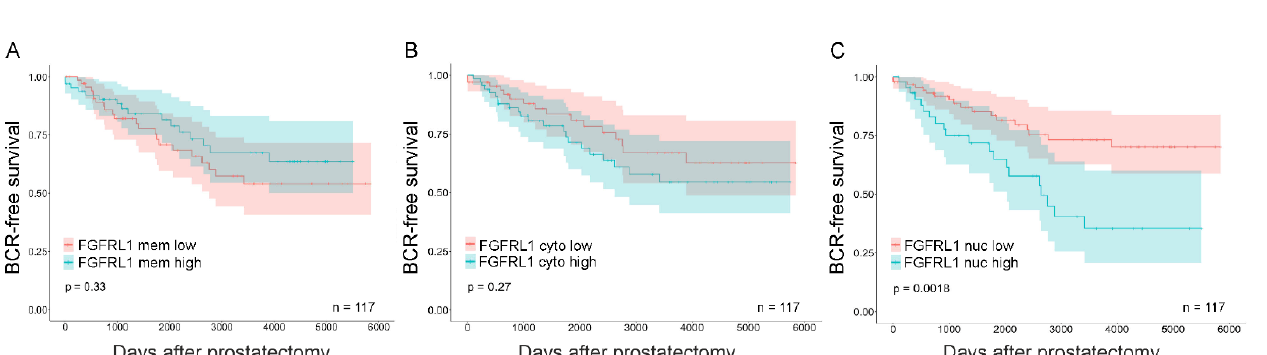
Figure 2. Kaplan–Meier analysis for membrane, cytoplasmic, and nuclear FGFRL1 expression associated with BCR-free patient survival in primary PCa. Primary PCa cases were stratified based on localized FGFRL1 IHC score. ( A ) low cell membrane (FGFRL1 mem low, red) versus high cell membrane (FGFRL1 mem high, blue), ( B ) low cytoplasmic (FGFRL1 cyto low, red) versus high cytoplasmic (FGFRL1 cyto high, blue), and ( C ) low nuclear (FGFRL1 nuc low, red) versus high nuclear (FGFRL1 nuc high, blue). 95% confidence interval is shown. n = 117, no neoadjuvant or adjuvant